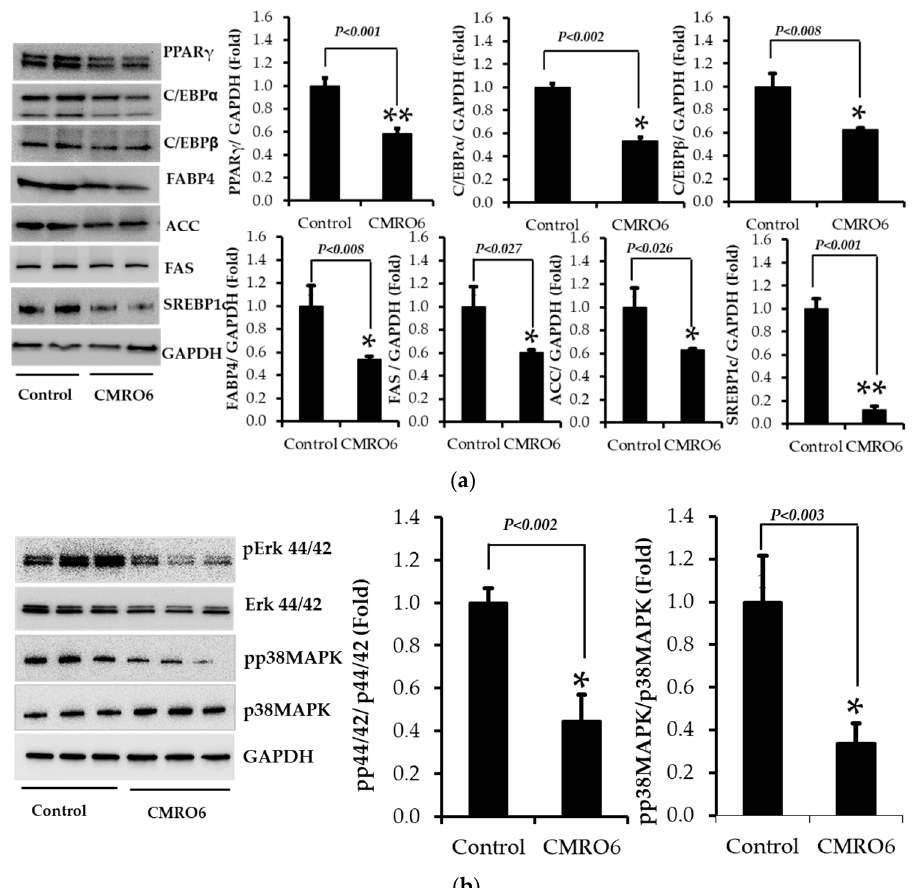
Figure 4. ( a ) Effect of CMRO6 on key transcriptional factors and their downstream targets. The proteins were extracted with extraction buffer on day 10 in the presence of protease and phosphatase inhibitors and quantified by the BCA method. Proteins were then separated by SDS-PAGE. The expression of C/CEB β , C/CEB α , PPAR- γ 2, SREBP-1c, FAS, ACC, and FABP4 proteins was detected with specific antibodies by the immunoblot method. The protein intensity was quantified by ImageJ software. CMRO6 treatment during differentiation reduced the translation level of C/CEB β , C/CEB α , PPAR- γ 2, SREBP-1c, FAS, ACC, and FABP4. Results are expressed as the mean ± STD, n = 3, * p values significant between control and treatment by an independent t -test. ( b ) Changes in Erk44/42 and P38MAPK signaling pathways in response to CMRO6 treatment. The proteins were and quantified by the BCA method. Proteins were then separated by SDS-PAGE. The phosphory- lating levels of Erk44/42 and p38MAPK were determined with specific antibodies by the Western blot method. The protein intensity was quantified by ImageJ software. Results are expressed as the mean ± STD of three replicates, n = 3, * p values (0.02-0.027), ** p values (0.001), control vs treatment by an independent t -test.